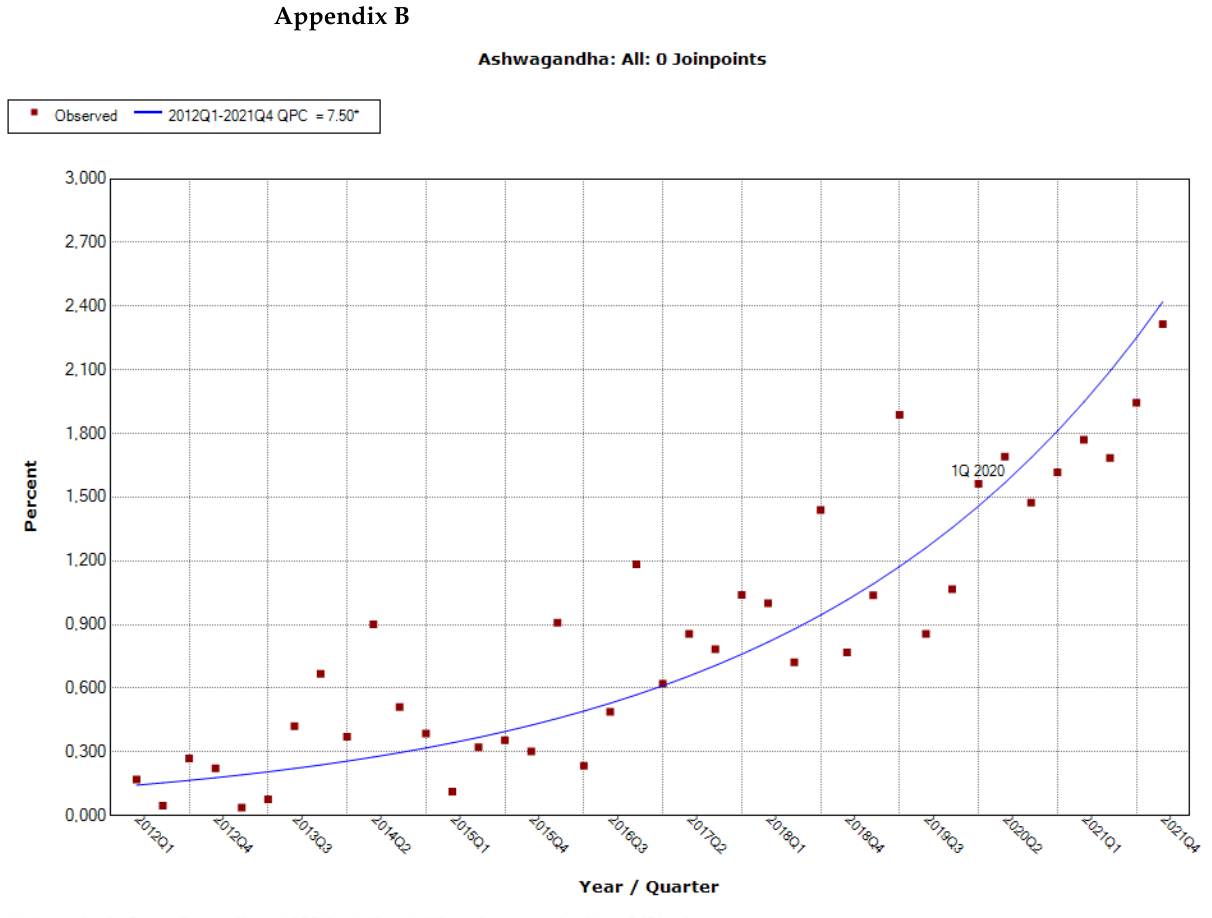
Figure A1. Percentage of products containing ashwagandha in individual quarters in the period from 2012 to 28 November 2021. Joinpoints mark trend turning points. The date above the observation indicates the moment of publication of the scientific opinion/resolution.